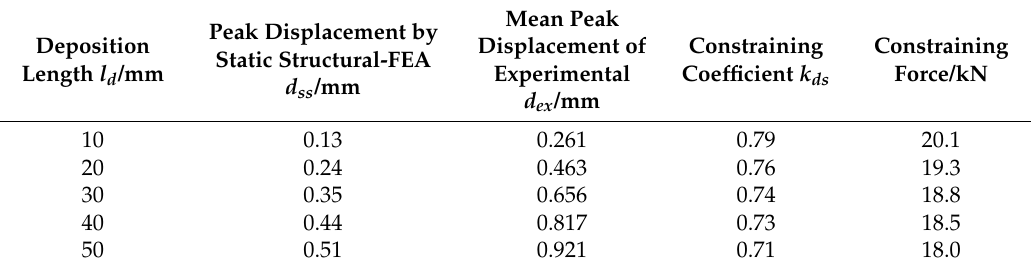
Table 2. Constraining coefficient values of the various deposition